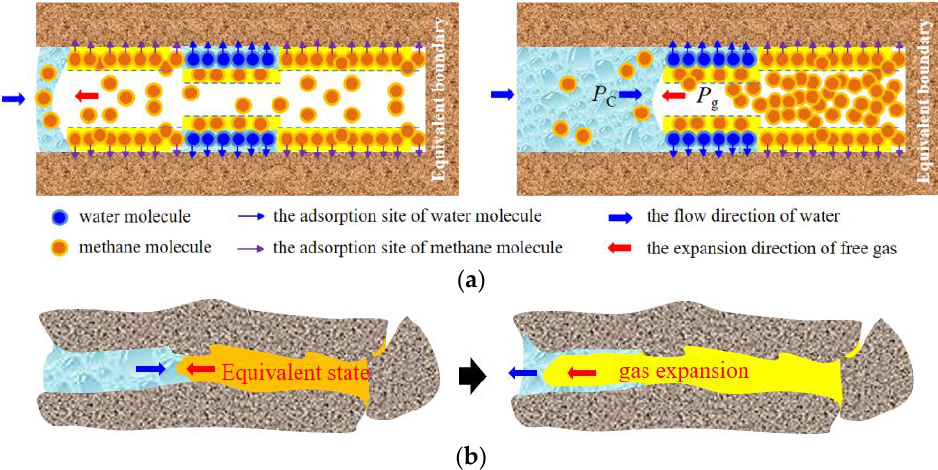
Figure 3. Change in the gas – water state in blind pores during the process of imbibition and drainage (according to Wang et al., [10]). ( a ) Change in the gas – water state in blind pores during the imbibition process. ( b ) Change in the gas – water state in blind pores during the drainage process.